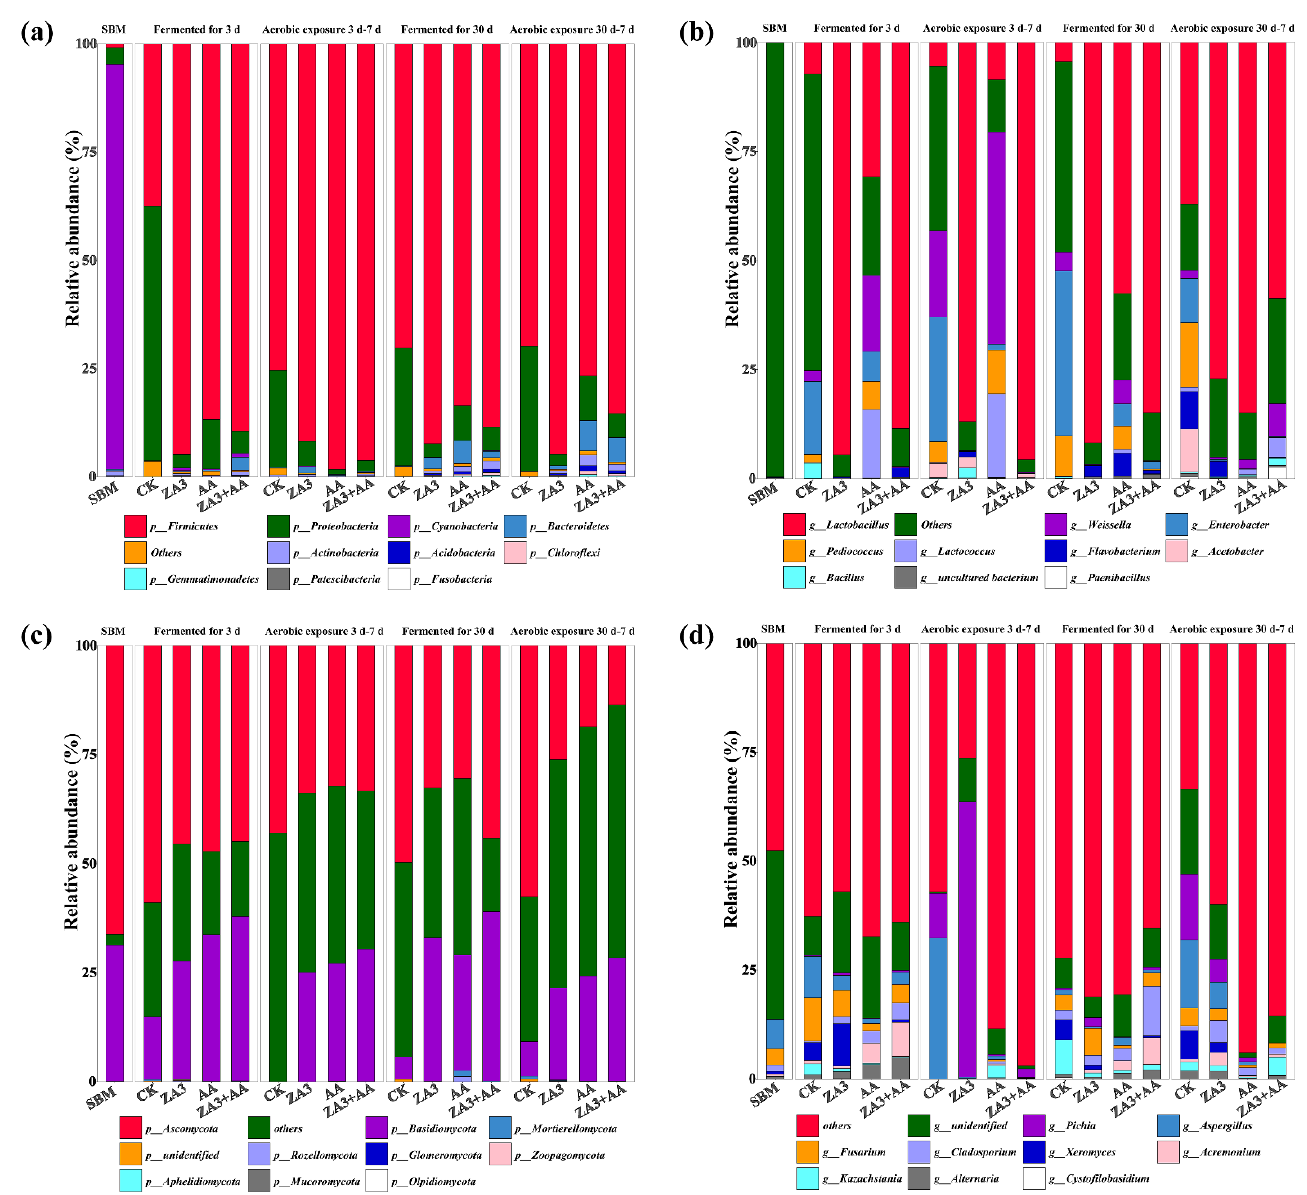
Figure 6. The bacterial and fungal communities of FSBM during fermentation and aerobic exposure. The phylum level of bacterial and fungal communities is shown in ( a , c ); and the genus level is shown in ( b , d ). d,